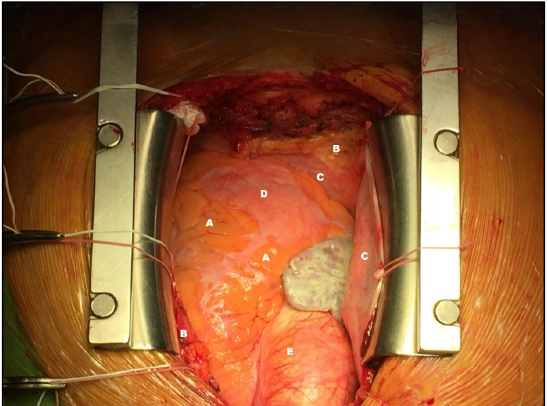
Figure 2. Anatomical description. Epicardial fat (A). Pericardial fat (B). Pericardium (C). The myo- cardium (D). Aorta (E). Photo collected from own practice and obtained with patient’s